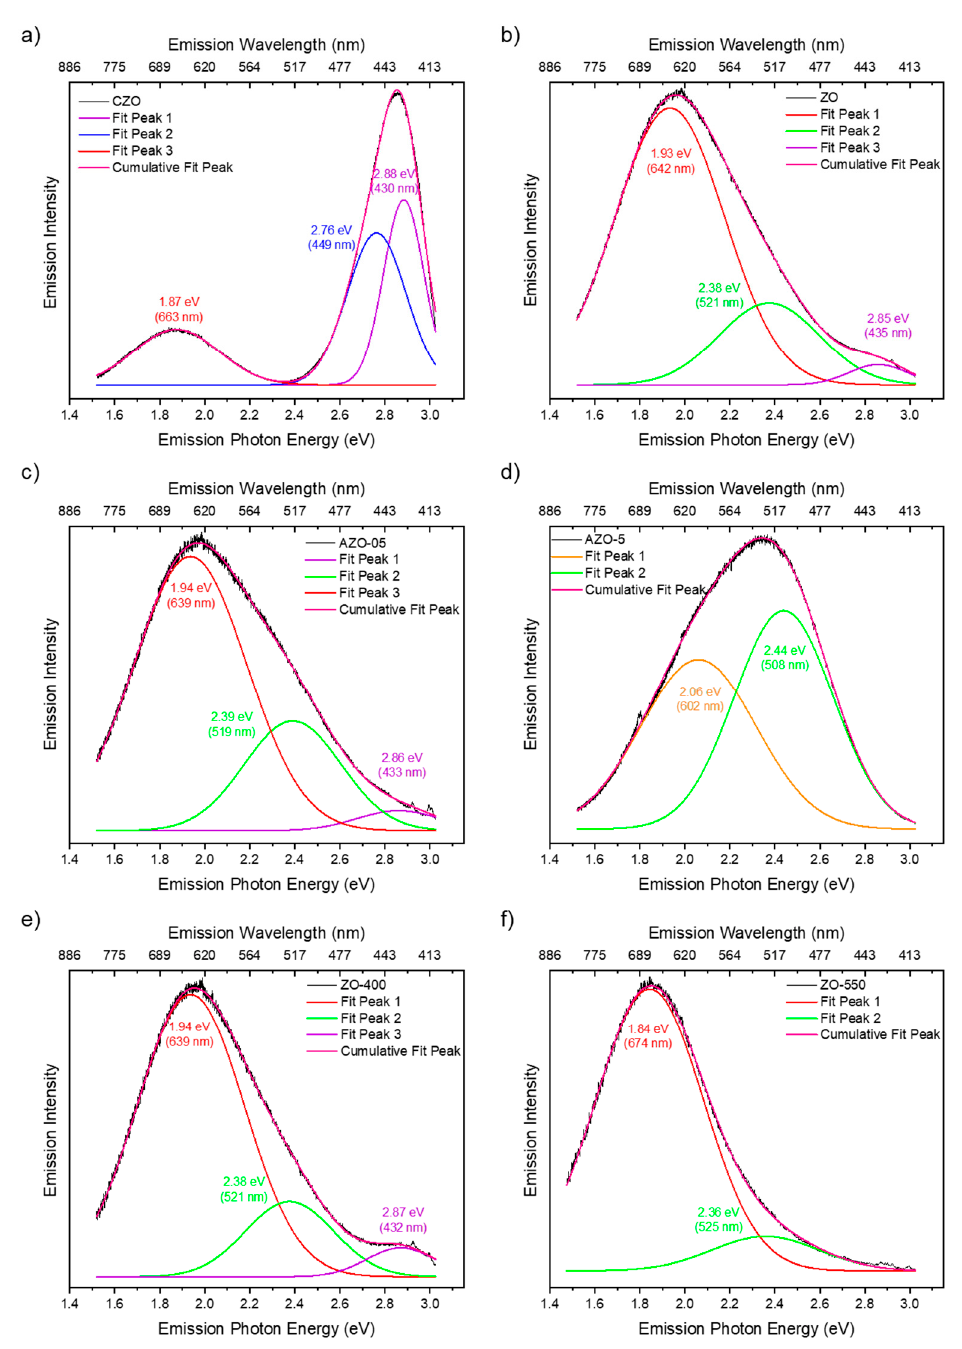
Figure 6. Gaussian deconvolution of emission spectra obtained under 405 nm excitation wavelength of CZO ( a ), ZO ( b ), AZO-05 ( c ), AZO-5 ( d ), ZO-400 ( e ) and ZO-550 ( f ). All the spectra can be fitted assuming two or three contributions in the orange/red, green/blue, and violet range, as reported in Table S2. The analysis confirmed that the red emission band of CZO, centered at about 660 nm, differs from the one detected in the other samples, where the emission band peaked at about 640 nm. This red band is the primary emission band in the ZO, even after annealing at 400 ◦ C (the relative content was about 75% of the overall emission in the undoped sample, 77% after annealing). When annealed at 550 ◦ C, the band is still present but red-shifted by about 35 nm. It should be noted that, different morphologies of the materials may affect scattering